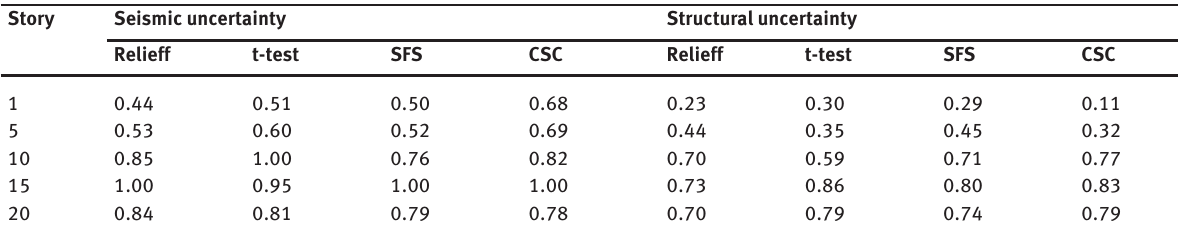
Table 5: Results of feature selection for sensitivity analysis of seismic and structural uncertainties. Story Seismic